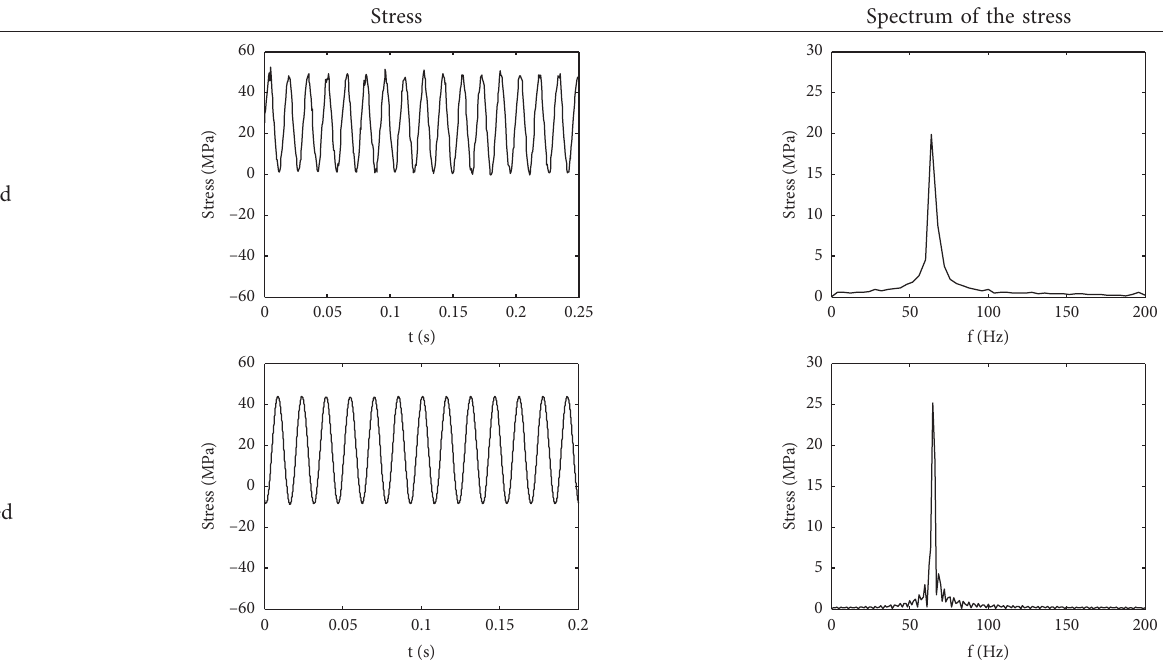
Table 11: Comparison of stress on the squirrel cage under support 2 upward 2mm ( h � 2